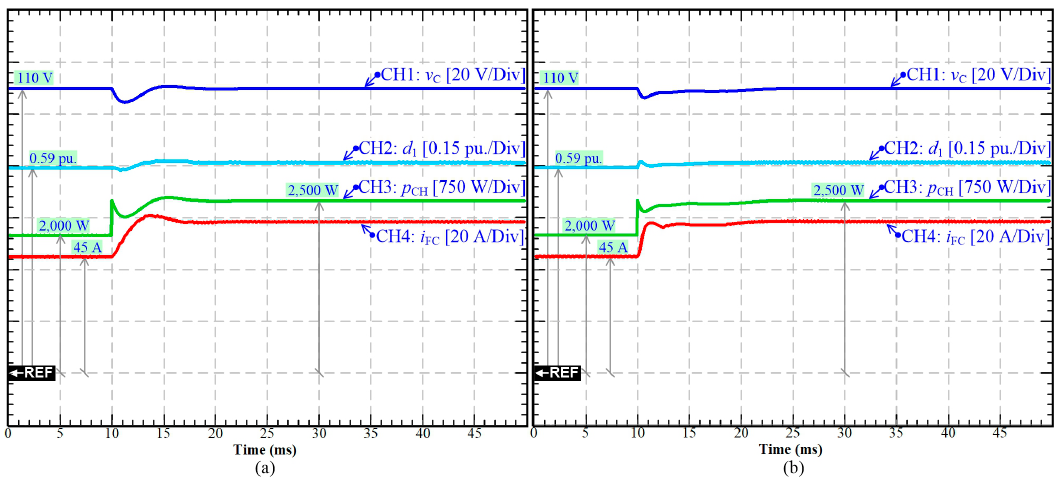
Figure 13. Simulation results: Dynamic behavior of the FC converter during a CRL step: 6.05 Ω to 4.84 Ω : ( a ) linear proportional-integral (PI) control law; ( b ) proposed adaptive Hamiltonian PI control law.